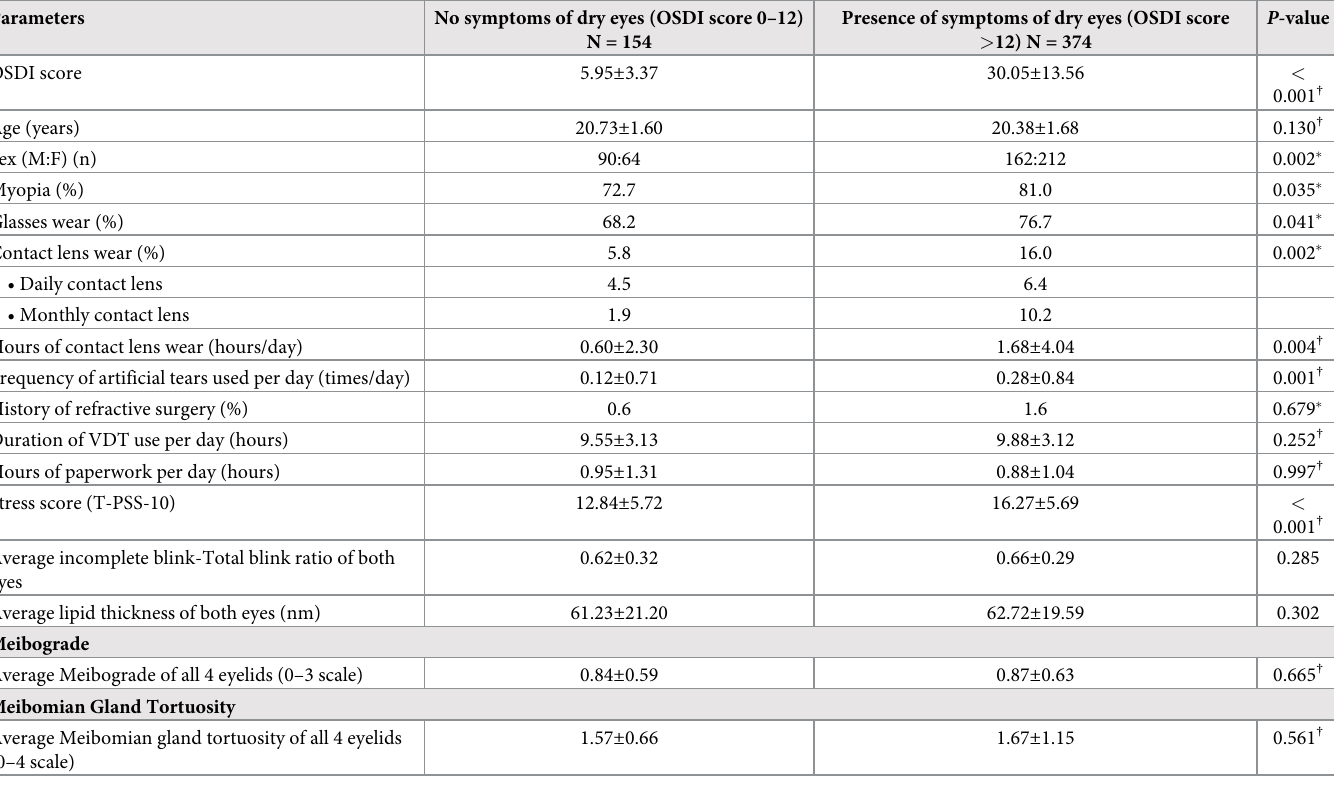
Table 1. Univariate analysis of potential risk factors for DES according to the presence and absence of dry eye